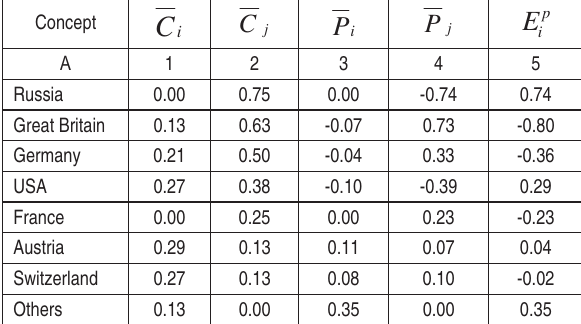
Table 4. Results of analysis of the processes regulating the mechanism of reinsurance according to areas